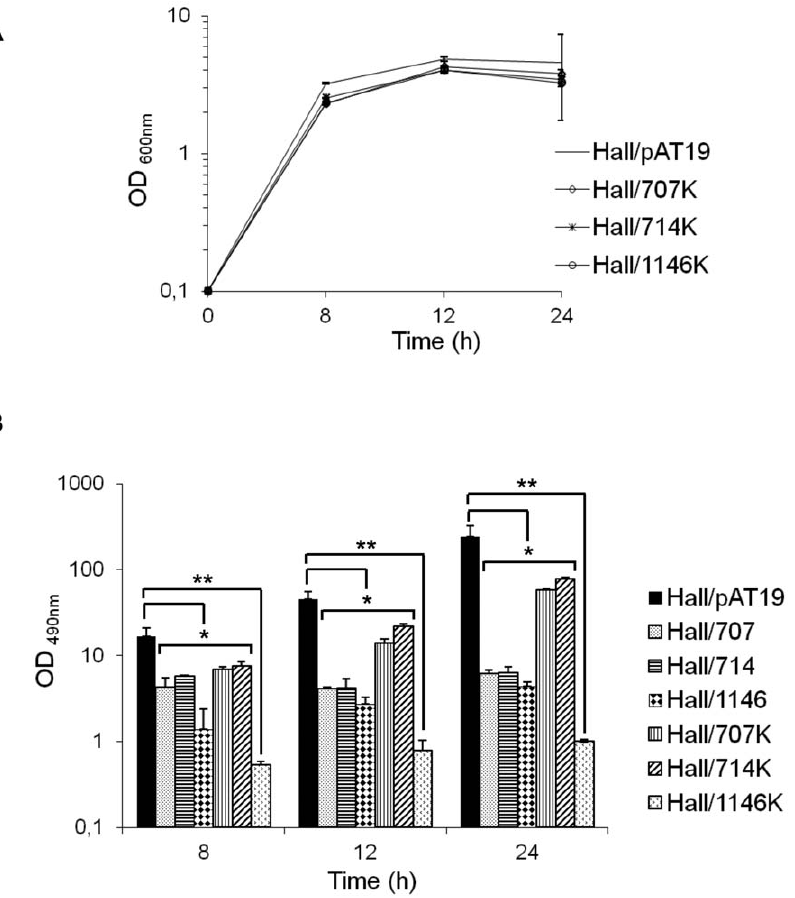
Figure 6. BoNT/A production in isogenic antisense strains targeting the SHK gene from three TCSs. (A) Growth kinetics of Hall/707K, Hall/714K, and Hall/1146K were similar to that of the control Hall/pAT19 strain as monitored by OD 600 measurement. (B) BoNT/A production assayed by ELISA was significantly reduced in the culture supernatants of Hall/707K, Hall/714K, and to a higher extent of Hall/1146K. Data are mean values + / 2 SD from 3 independent experiments, *P , 0.05 and **P , 0.005.